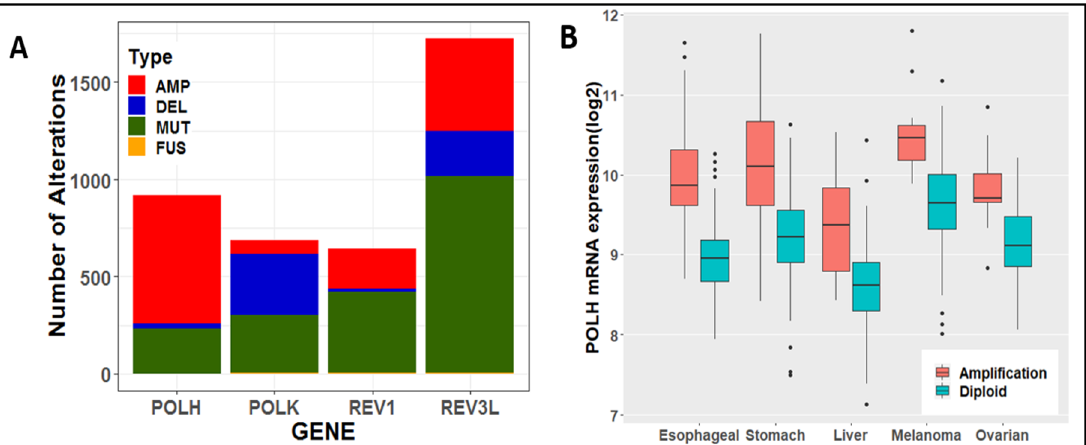
Figure 1. Specialized DNA Polymerase Gene Alterations in Cancer. Thirty tumor groups ( n = 65,690 samples) were queried using cBioportal (www.cbioportal.org) and public datasets available as of 1 September 2018. ( A ) The total number of POLH, POLK, REV3L, and REV1 gene alterations found in all tumor types are categorized into mutations (green bars), amplifications (red bars), deep deletions (blue bars), fusions (orange bars). Fusion events found in tumors were extremely rare: POLH has 2; POLK has 3; REV1 has 3; REV3L has 5. Multiple alterations with mutations were classified as mutations. Multiple alterations with fusions only occurred with amplifications and thus were designated as amplifications. ( B ) Correlation of POLH gene expression with copy number status. Individual TCGA PanCancer Atlas datasets for each type of cancer with mRNA expression from RNA-seq data sets were extracted as RSEM and graphed as box-and-whisker plots.